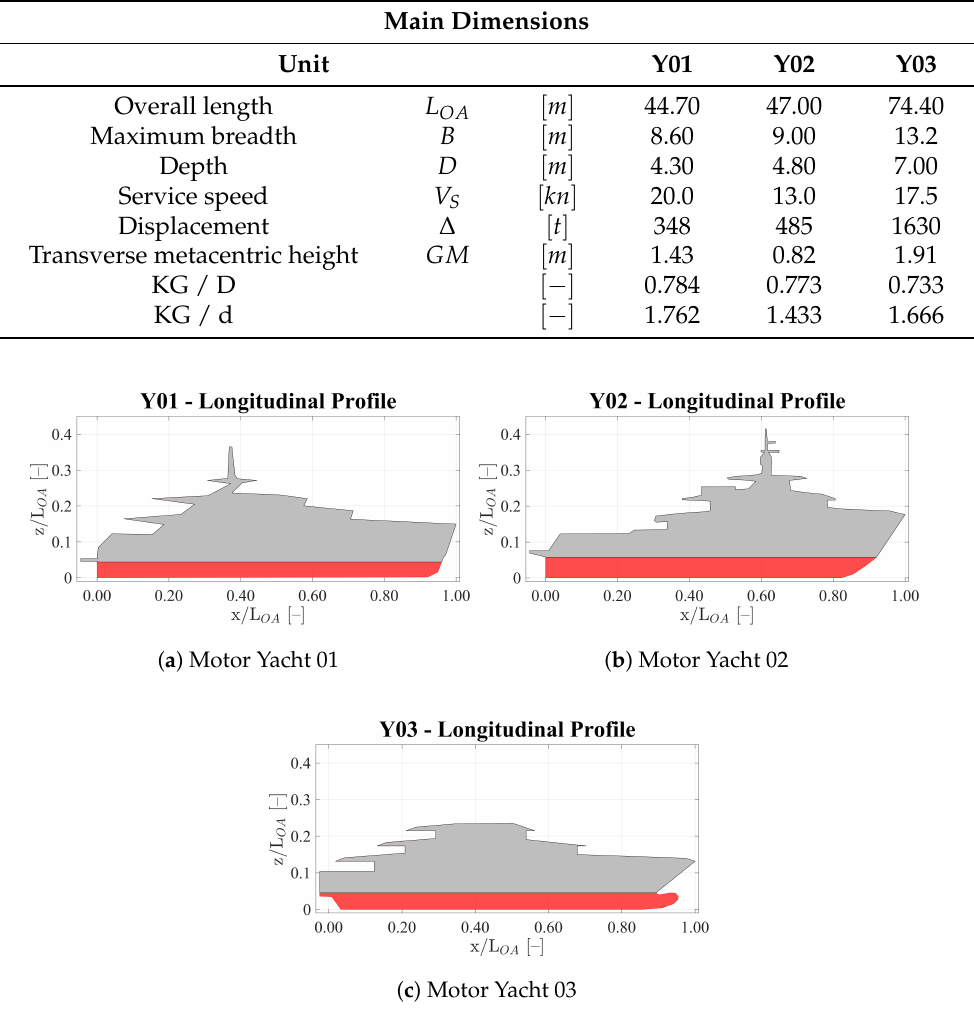
Table 2. Main particulars of the investigated units.